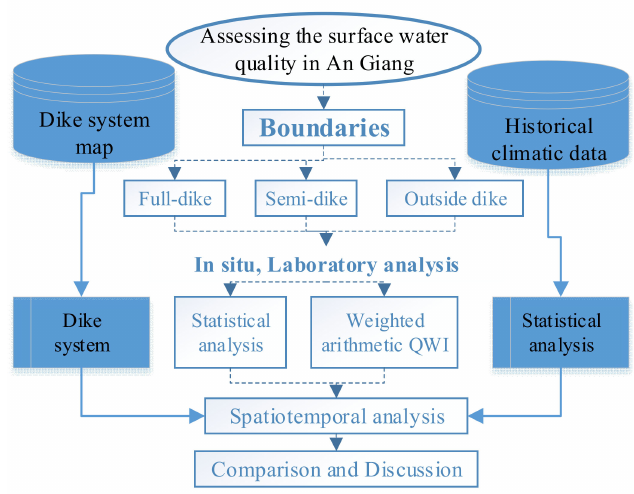
Figure 3. Flowchart for study